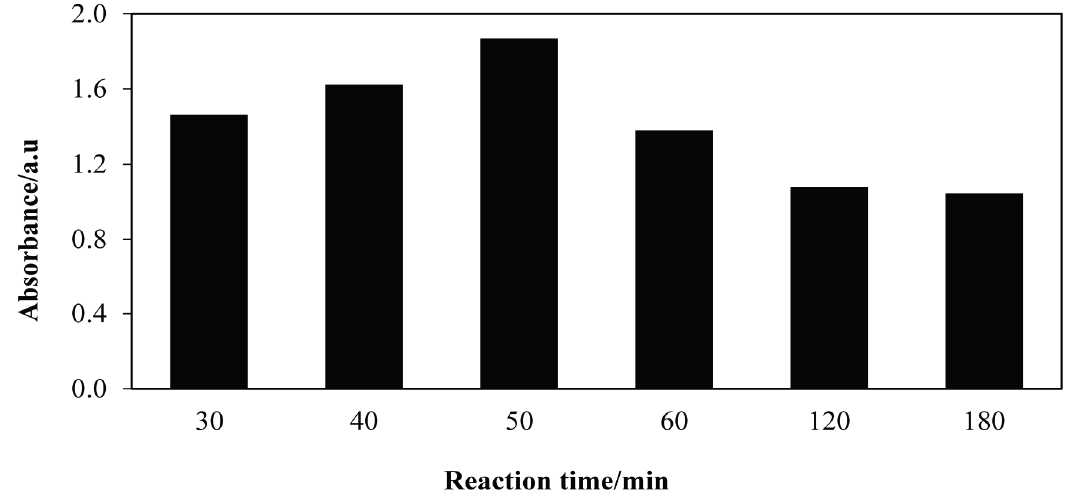
Figure 2. The effect of reaction time on the aminolysis reaction at 364 nm. Reaction conditions: Crude palm oil, 6 mmol; hydroxylamine hydrochloride, 1 mmol; CAL-A lipase, 20.0 mg; hexane, 3 mL; deionized H 2 O, 3 mL; temperature, 70 °C; shaking rate, 150